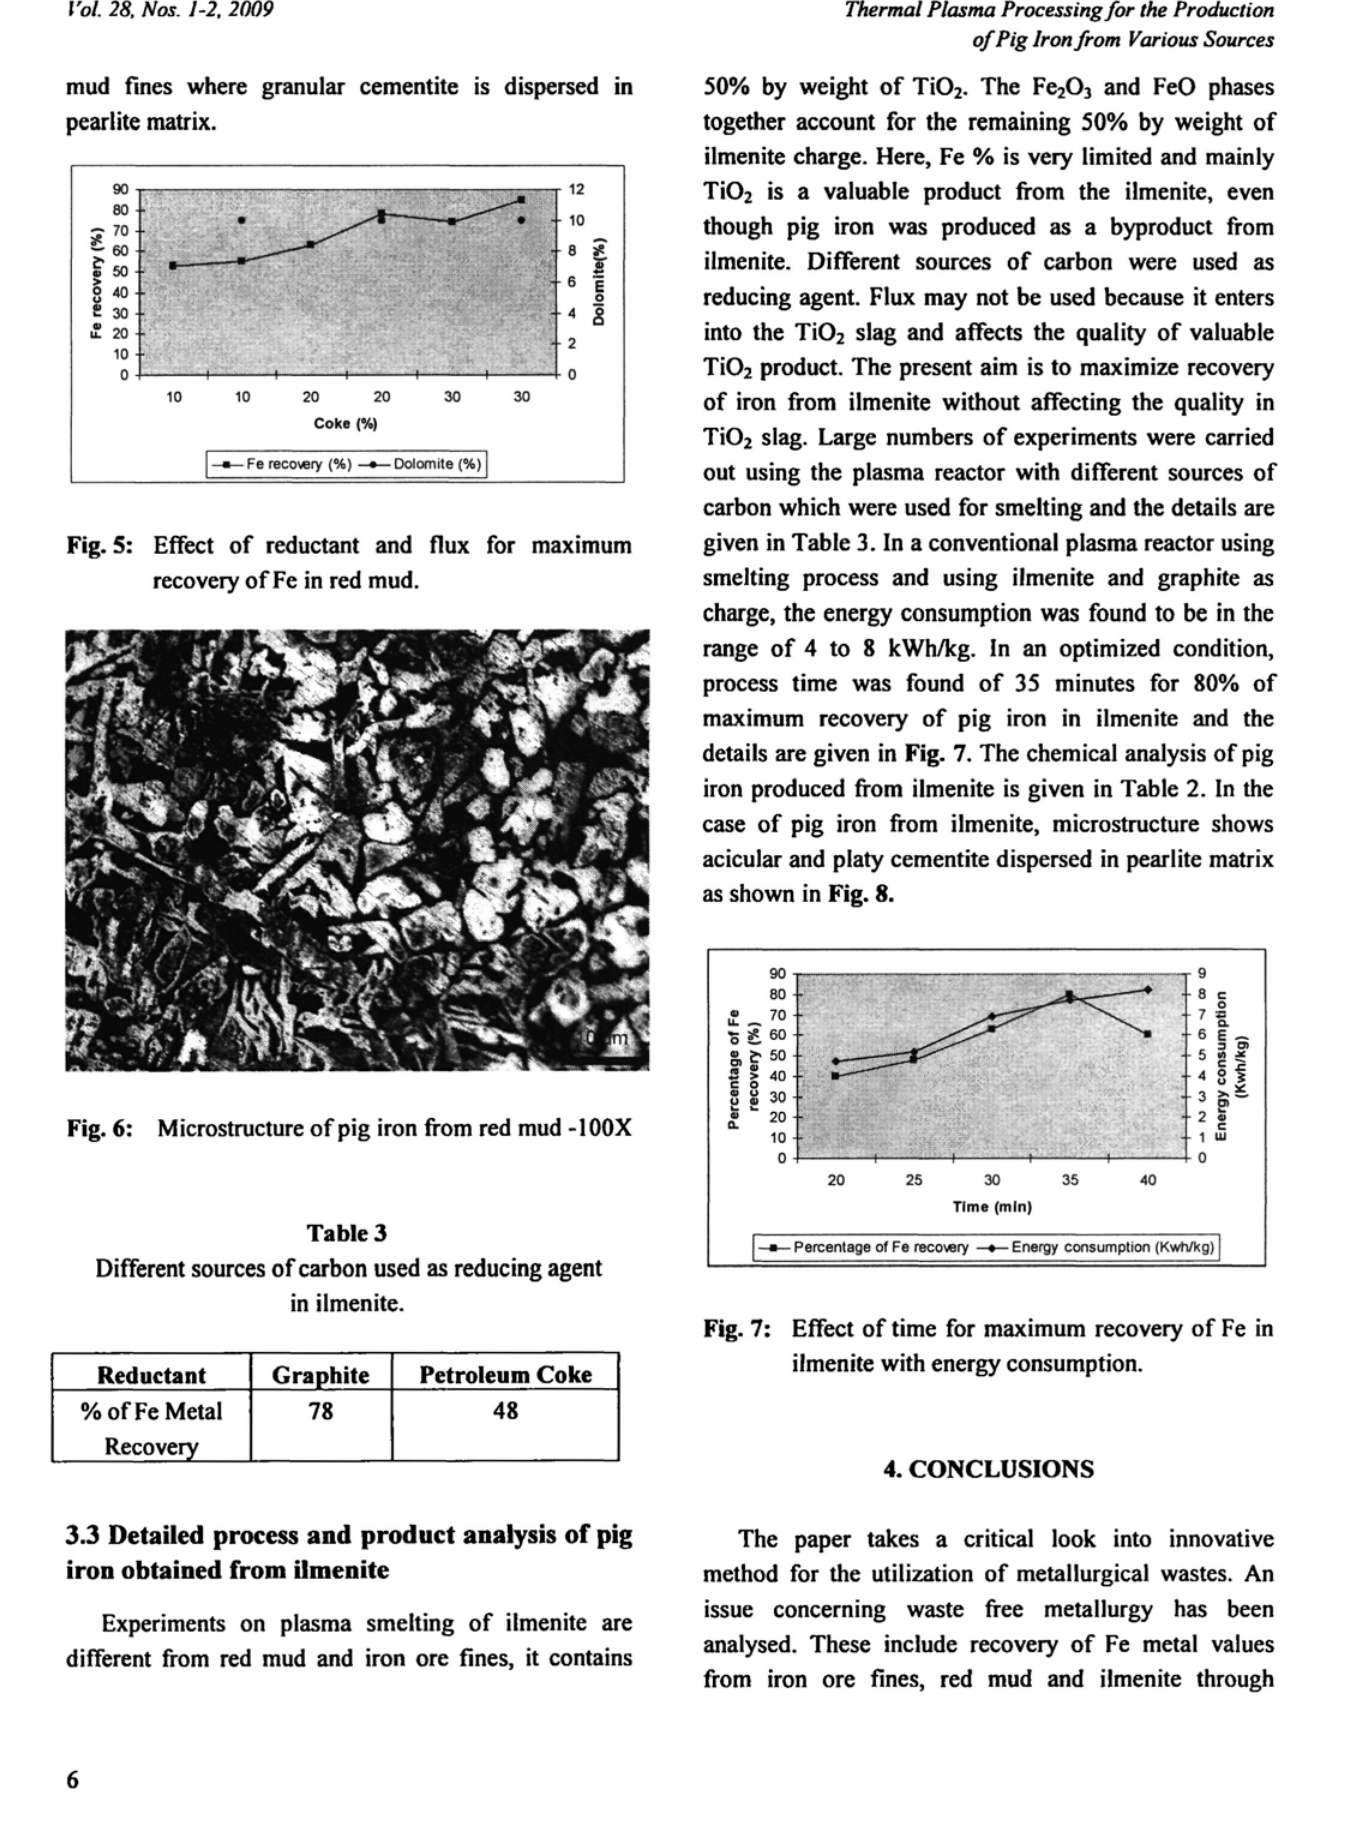
Fig. 7: Effect of time for maximum recovery of Fe in ilmenite with energy